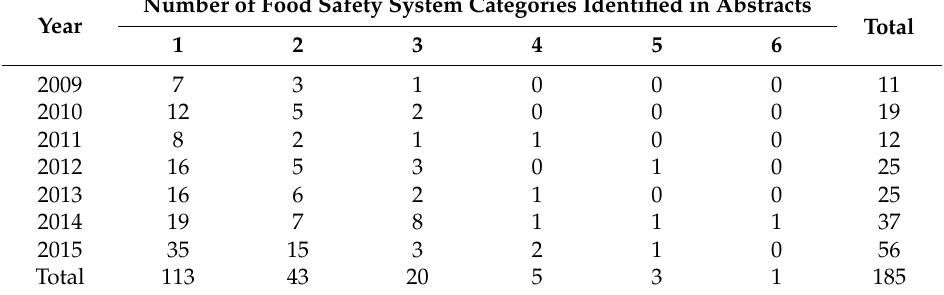
Table 3. Cross tabulation of publication year and the number of food safety system categories